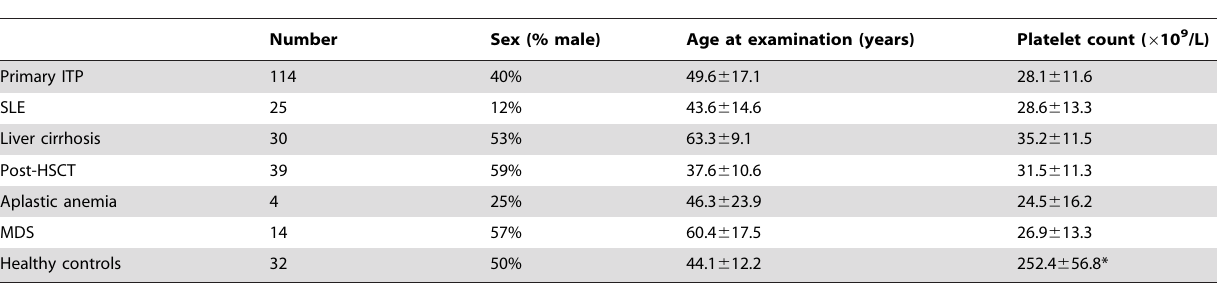
Table 1. Demographic features and platelet count of subjects enrolled in this study.